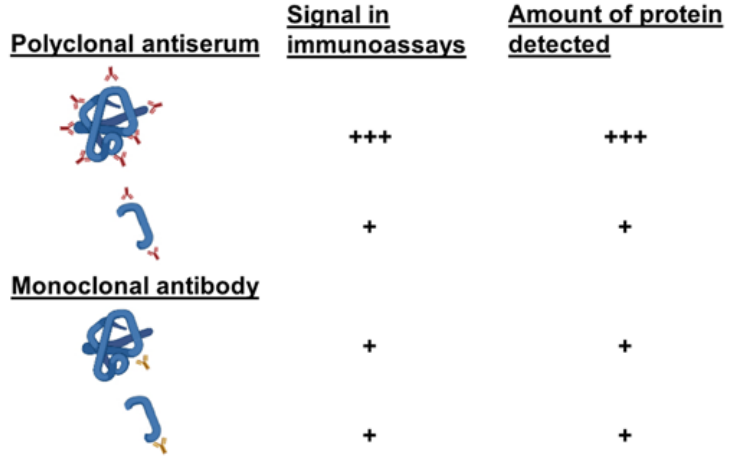
Figure 5. Differences in reactivity and quantification of fossil proteins (short peptide) in comparison to the native protein in assays with a polyclonal antiserum or a monoclonal antibody. Figure created in BioRender.com.